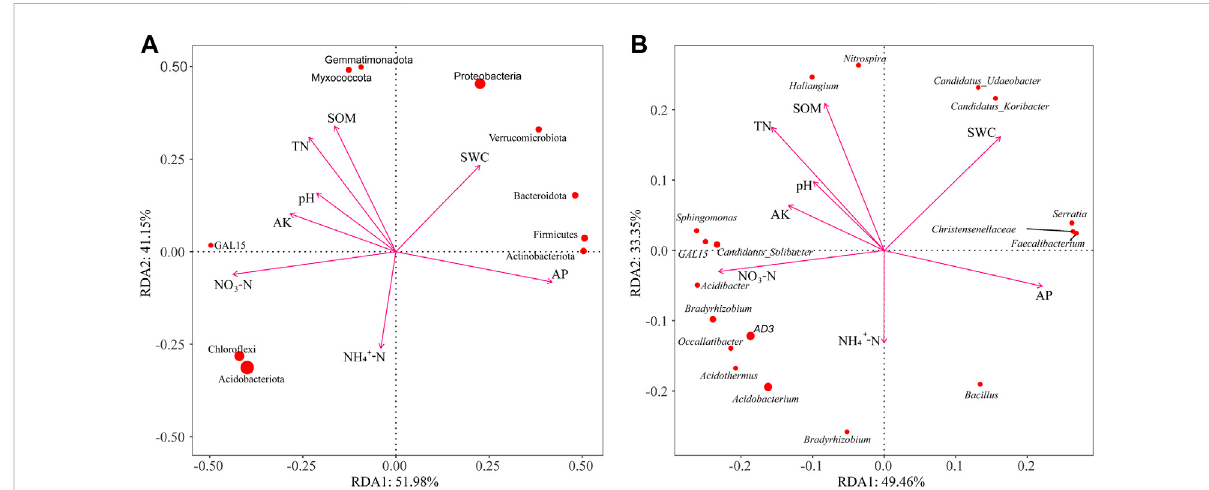
FIGURE 7 Redundancyanalysis(RDA) of soilbacteriaatthephylum andgenuslevels. Results of theRDA ofbacteriaatthephylum (A) and genus (B) levels. SWC, soil water content; TN, soil total nitrogen content; NH 4 + -N, ammonium nitrogen content; NO 3 − -N, nitrate nitrogen content; AP, available phosphorus content; AK, available potassium content; SOM, soil organic matter